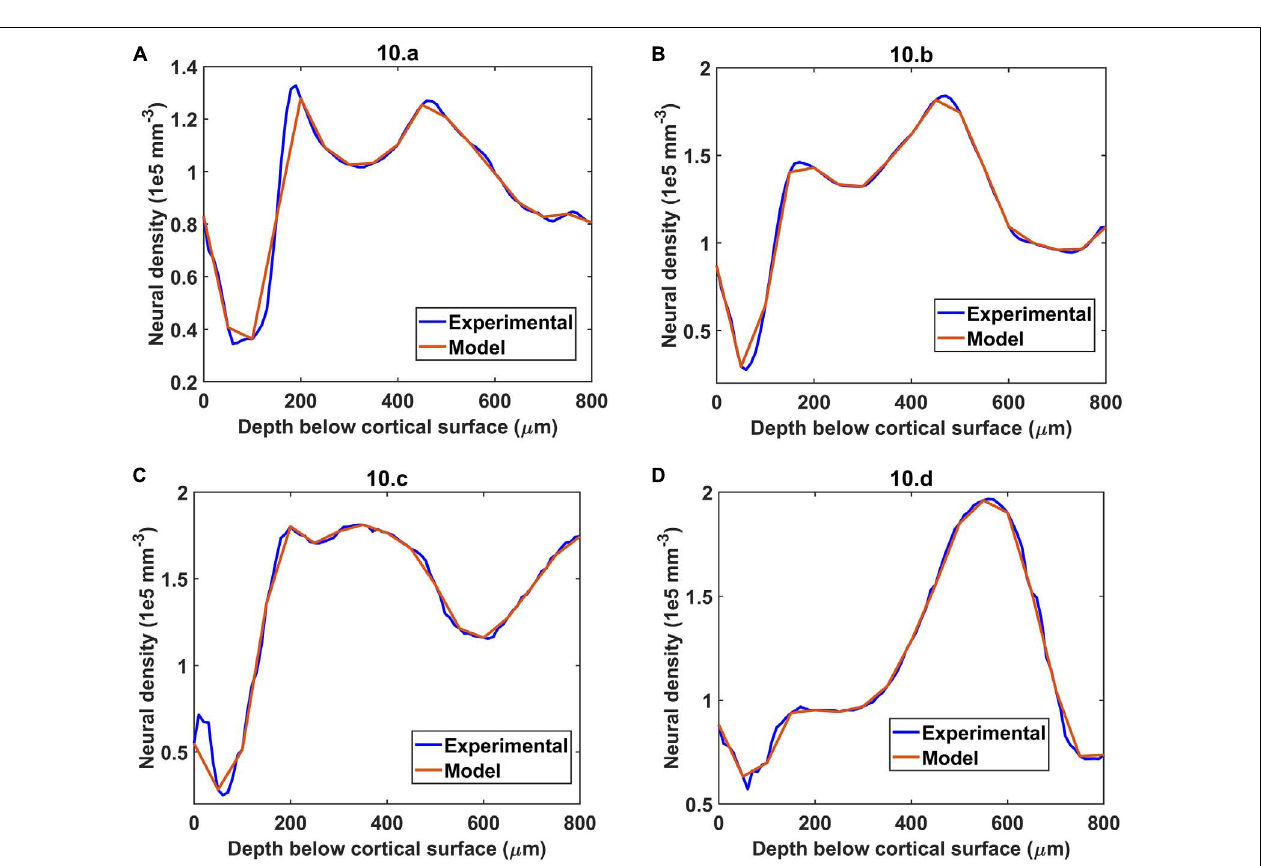
FIGURE 4 | The simulation of neural distribution along the depth of the cortex in four different regions (A–D) , The title shows the reference figure number in Tsai et al. (2009) which was reconstructed by the model. The red plot shows the reconstructed neural cell distribution from the model.